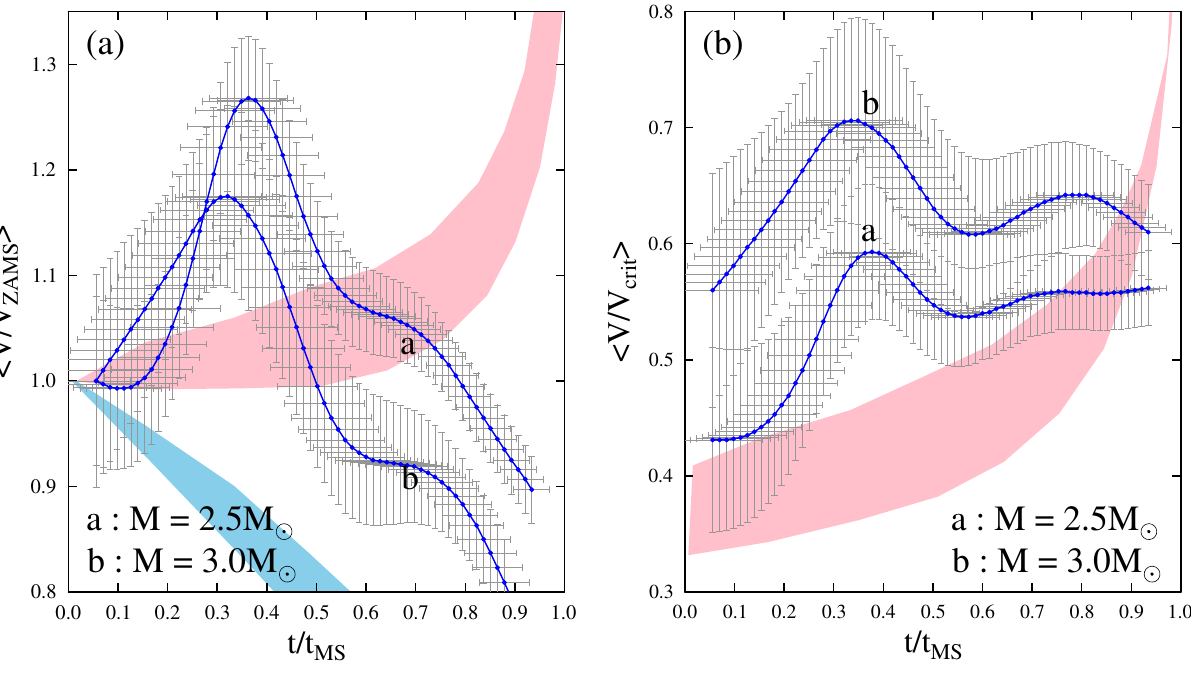
Figure 33. ( a ) Evolution of the averaged equatorial velocity ratio (cid:104) V / V ZAMS (cid:105) in the MS lifetime span, where V ZAMS is the true equatorial velocity of stars on the ZAMS having masses 2.5 and 3 M (cid:12) . The shaded region corresponds to the theoretical evolution of the V / V ZAMS ratios for strict rigid rotators (pink) and differential rotators (blue). ( b ) Evolution of the equatorial velocity ratio (cid:104) V / V crit (cid:105) in the MS life time span. The ratios of true equatorial velocities are calculated for two masses: 2.5 and 3 M (cid:12) . The shaded regions correspond to the theoretical evolution of the (cid:104) V / V crit (cid:105) ratio of strict rigid rotators whose total angular momentum is J = J crit (pink). Let us note that, in this figure, the TAMS ratio V / V ZAMS was used, while in Figure 32, we have V V / V λ , where V V replaces V ZAMS and V λ 1 1 indicates the mean velocities per luminosity class. Adapted from Zorec and Royer [289]. Figure 34 shows the comparison of the evolution of observed velocity ratios (cid:104) V / V ZAMS (cid:105) and (cid:104) V / V crit (cid:105) presented in Zorec and Royer [289] with those obtained by Ekström et al. [541] for model stars with mass M = 3 M (cid:12) and different initial (cid:104) V / V ZAMS (cid:105) . The respective model V ZAMS values correspond to the initial velocities V in the ordinates in Figure 34b, where velocities are presented as ratios (cid:104) V / V crit (cid:105) . The differences between observations